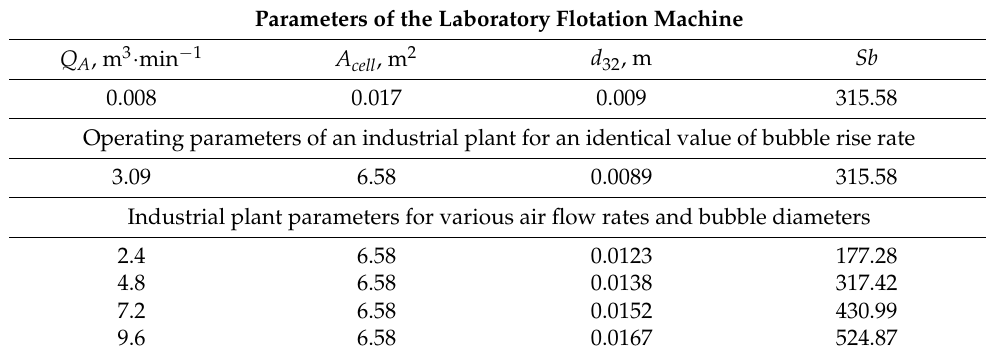
Table 5. Parameters for modeling of gas distribution in flotation cell.